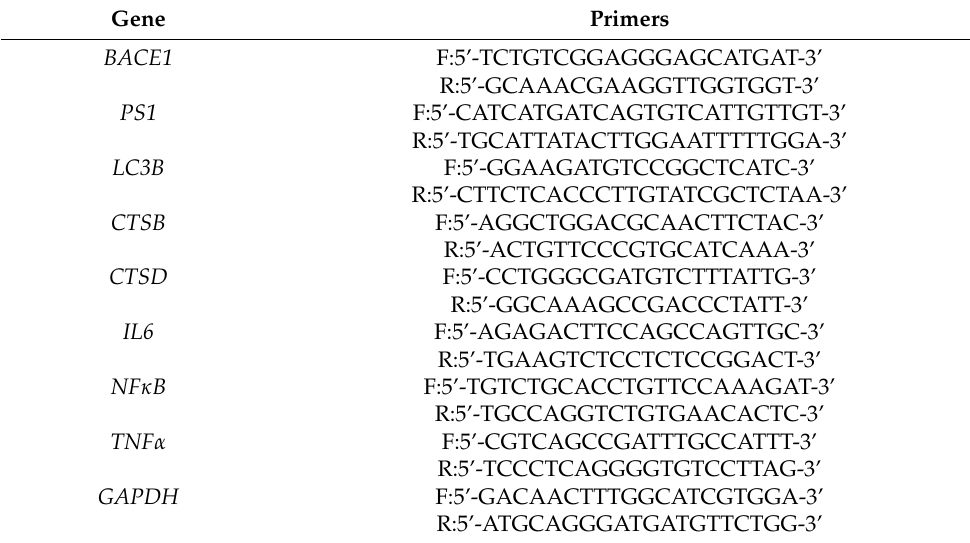
Table 1. Rat primer sequences used for quantitative real-time